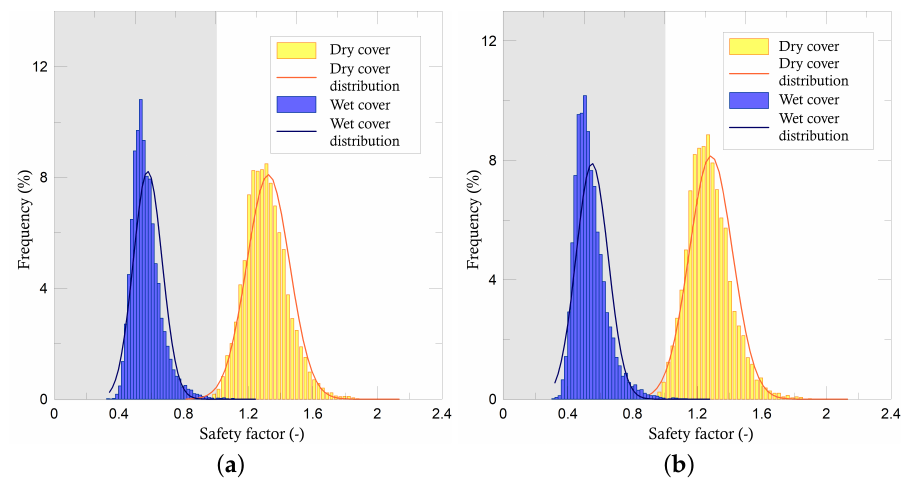
Figure 14. Results of the probabilistic analysis for the water table conditions considered: ( a ) slope S1 and ( b ) slope S2.